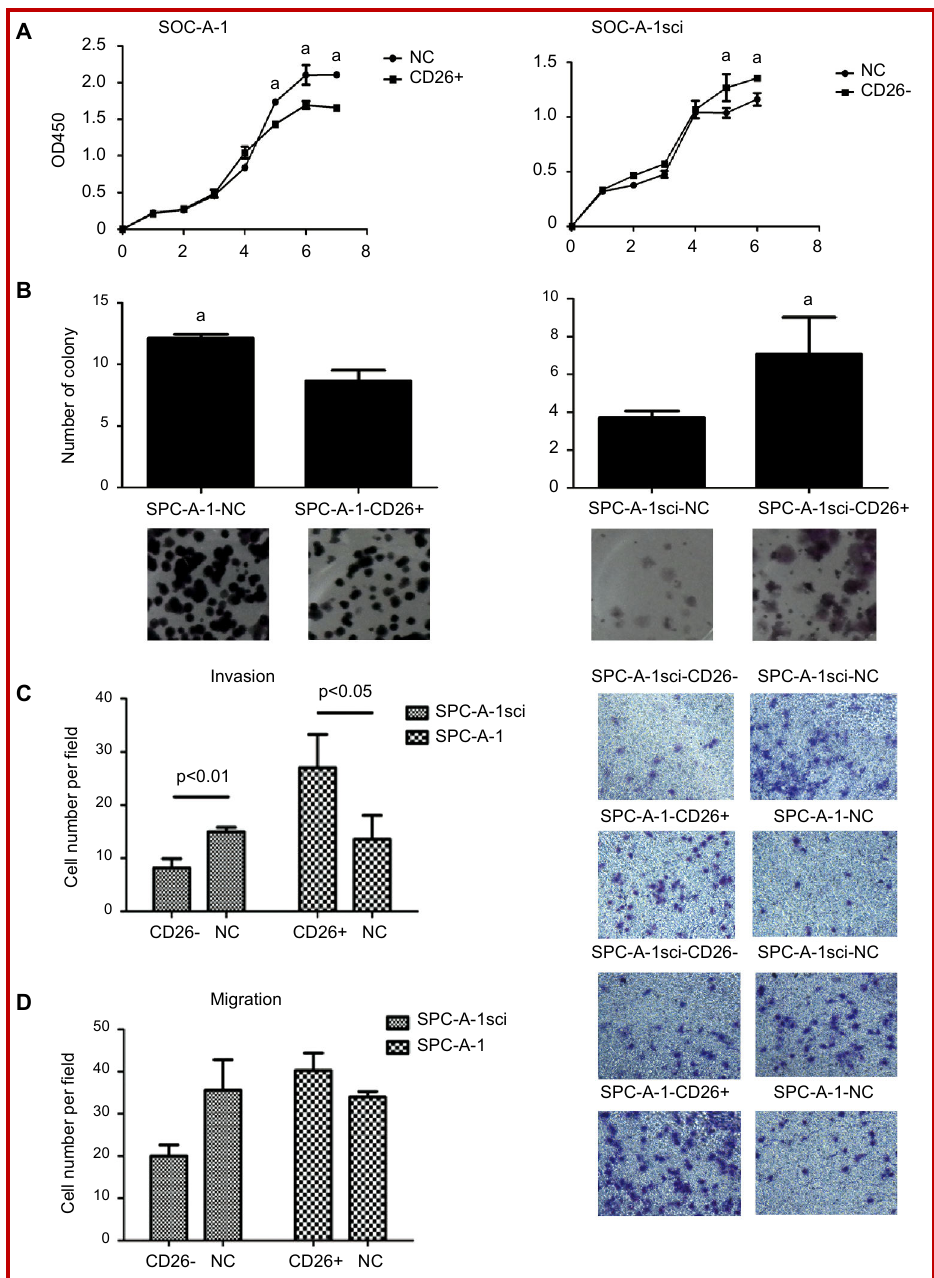
Figure 2: Effects of CD26 expression on cell migration and invasion. (A) In vitro growth curves for infected cells. Cells (2 × 104/ well) were seeded in 96-well plates, and cell proliferation was measured by a CCK8 assay. The results are expressed as the mean ± SD; a p<0.05. (B) Cell colony formation of infected cells. Cells (1 × 10 4 /well) were cultured in 24-well plates. Colonies were photographed and counted after two weeks. The results are expressed as the mean ± SD; a p<0.05. (C and D). Transwell invasion and migration assays with infected cells. For invasion assays (C), cells (1 × 10 5 /well) were seeded into Matrigel-coated Transwell plates and cultured for 24 hours at 37°C. For migration assays (D), cells (2.5 × 10 4 /well) were seeded into non-coated Transwell plates and cultured for 16 hours at 37°C. The cells that had invaded or migrated to the underside of the inserts were then stained with H and E, photographed (lower) and quantified (upper) at 400× magnification. All experiments were repeated three times. The results are expressed as the mean ± SPC-A-1sci cells is due to the acquisition of other metastasis-promoting properties, and not due to a faster growth rate.